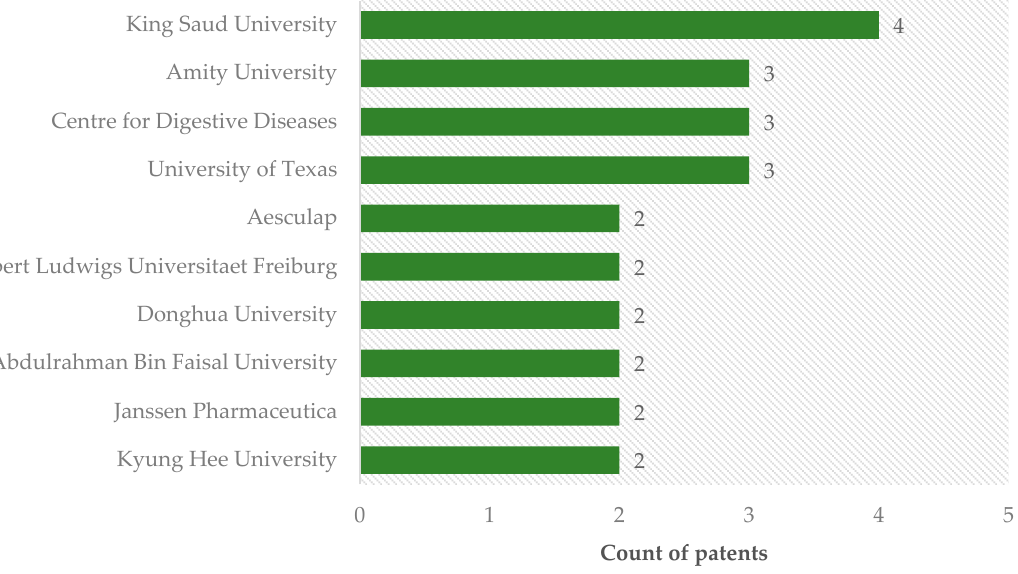
Figure 5. Patents issued on the use of silver nanoparticles in dentistry by depositors.